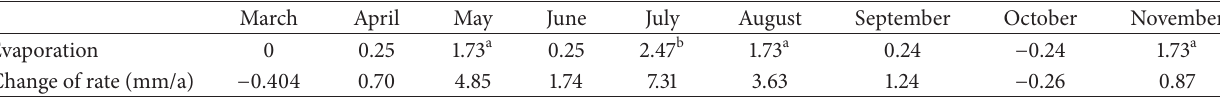
Table 7: 𝑍 values of M-K tests and rate of monthly evaporation